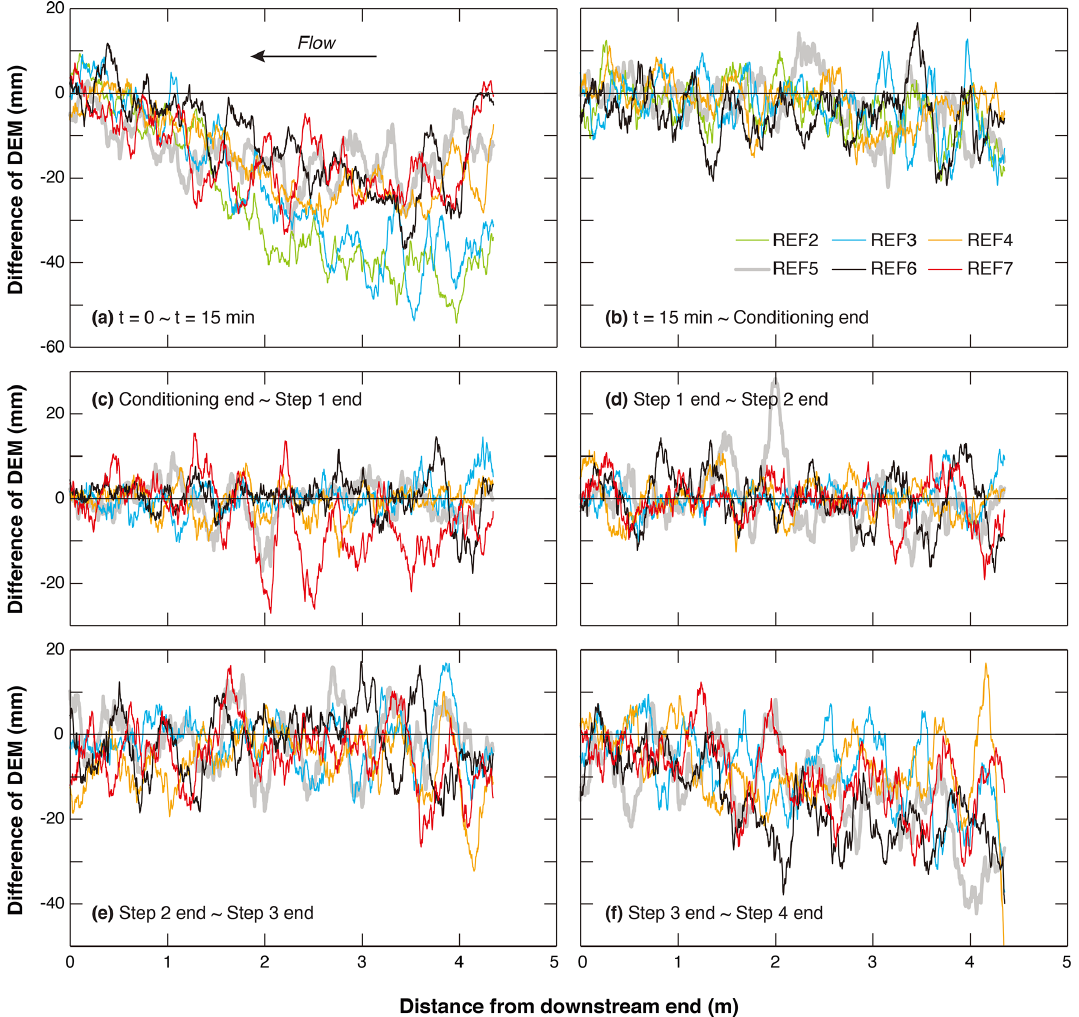
Figure 3. Spatial distribution of elevation difference from cross-sectionally averaged longitudinal DEM during the experiment: (a) from the beginning of the experiment to t = 15min, (b) from t = 15min to the end of the conditioning phase, (c) from the end of the conditioning phase to the end of step 1 of the hydrograph phase, (d) from the end of step 1 to the end of step 2 of the hydrograph phase, (e) from the